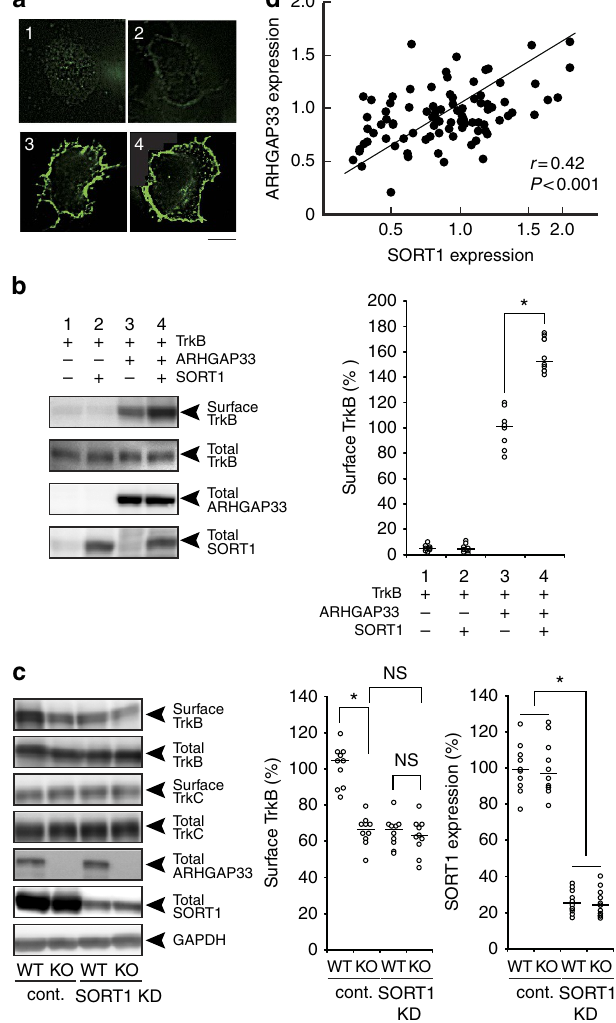
Figure 7 | Cooperative facilitation of TrkB trafficking by ARHGAP33 and SORT1. ( a , b ) Increased TrkB surface expression by ARHGAP33 and SORT1. HEK293T cells were transfected with TrkB, ARHGAP33 and SORT1 as indicated in b (1–4). Representative data from eight independent experiments of immunostaining of surface TrkB in HEK293T cells with an antibody against the extracellular region of TrkB ( a ). Scale bar, 10 m m. Representative blots (left) and the quantification of the surface TrkB (right) ( b ). Biotinylated cell-surface proteins were immunoblotted with the indicated antibodies. The surface expression of TrkB was enhanced by simultaneous expression of ARHGAP33 and SORT1 compared with the expression of ARHGAP33 alone (each n ¼ 8; ARHGAP33 alone versus ARHGAP33 and SORT1, P ¼ 0.004, Kruskal–Wallis test followed by post hoc Steel–Dwass tests). Western blots show representative results from eight independent experiments. The averaged value of surface TrkB level in cells expressing ARHGAP33 alone (lane 3) was set to 100%. * P o 0.05. Bars show median values. ( c ) Requirement of SORT1 in ARHGAP33-mediated TrkB trafficking. Biotinylated cell-surface proteins were immunoblotted with the indicated antibodies. Representative blots (left), quantification of surface TrkB expression (centre) and quantification of SORT1 expression (confirmation of SORT1 knockdown; right; each n ¼ 10; surface TrkB, WT versus ARHGAP33 KO in control neurons, corrected P ¼ 6.0 (cid:2) 10 (cid:3) 4 ; WT versus ARHGAP33 KO in SORT1 knockdown neurons, corrected P 4 0.05; ARHGAP33 KO versus ARHGAP33 KO plus SORT1 knockdown, corrected P 4 0.05, Mann–Whitney U -test with the Ryan’s correction). Western blots show representative results from 10 independent experiments performed using neurons from different mice. The averaged values of WTmice in the control neurons were set to 100%. * P o 0.05; cont., control; KD, knockdown; NS, not significant. Bars show median values. Note that the MISSION shRNA construct (TRCN0000034496) was used. ( d ) Strongly correlated expression of SORT1 and ARHGAP33 in immortalized lymphocytes from human blood (r ¼ 0.42, P o 0.001, Spearman’s rank order correlation test). Quantitative RT-PCR analysis of ARHGAP33 and SORT1 expression in immortalized lymphocytes was performed. Then, the levels of SORT1 and ARHGAP33 expression in each sample were